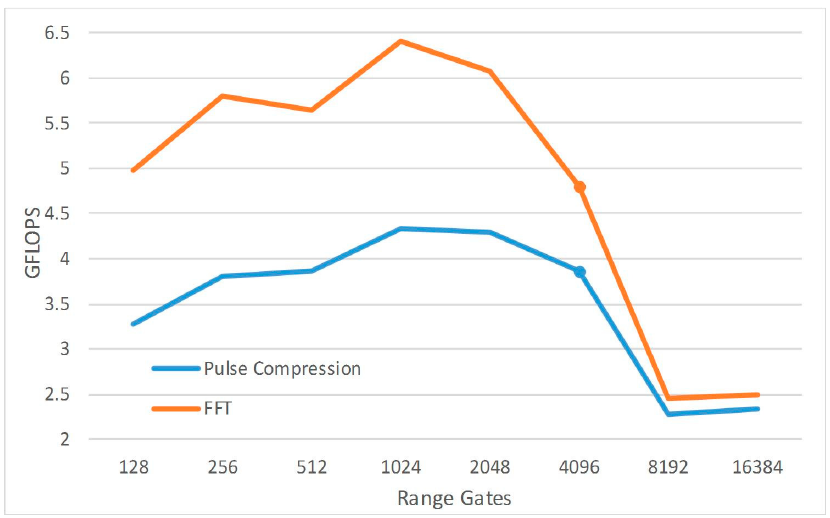
Figure 13. Performance of pulse compression and fast Fourier transform (FFT) vs. different numbers of range gates.